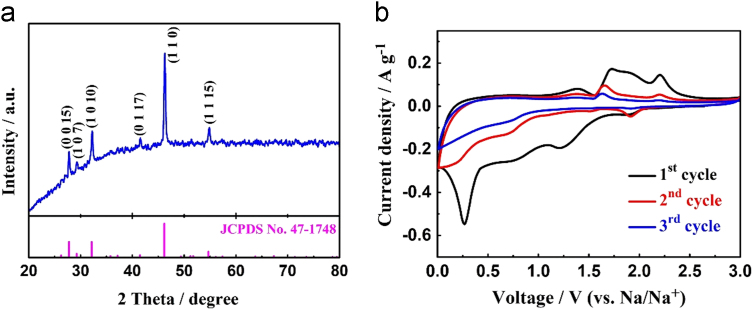
(a) XRD pattern of pure Cu9S5. (b) CV files of pure Cu9S5 electrode at 0.2 mV s−1.